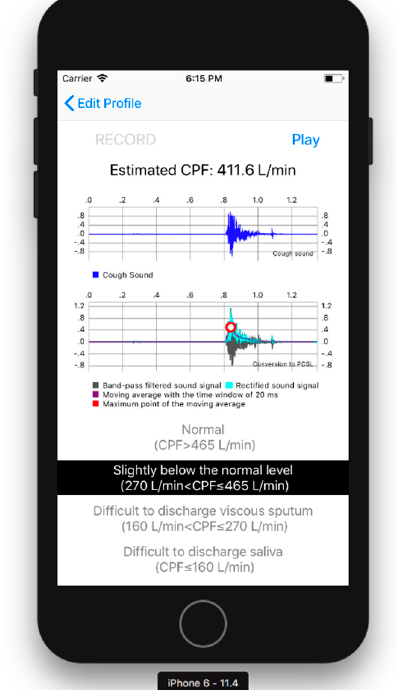
Figure 3. Results display part. The blue solid line represents the measured cough sound signal. The light blue solid line represents the rectified sound signal. The purple solid line represents the moving average with a time window of 20 ms. The red dot represents the maximum point of the moving average.